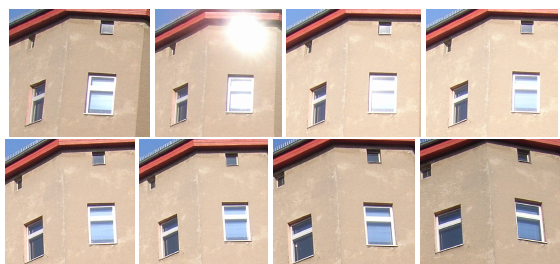
Figure 1. Eight different views of four windows of one fac¸ade. While the colour of pixels showing the surrounding masonry only changes slightly, the brightness of pixels of the window panes can vary a lot, especially when specular reflections